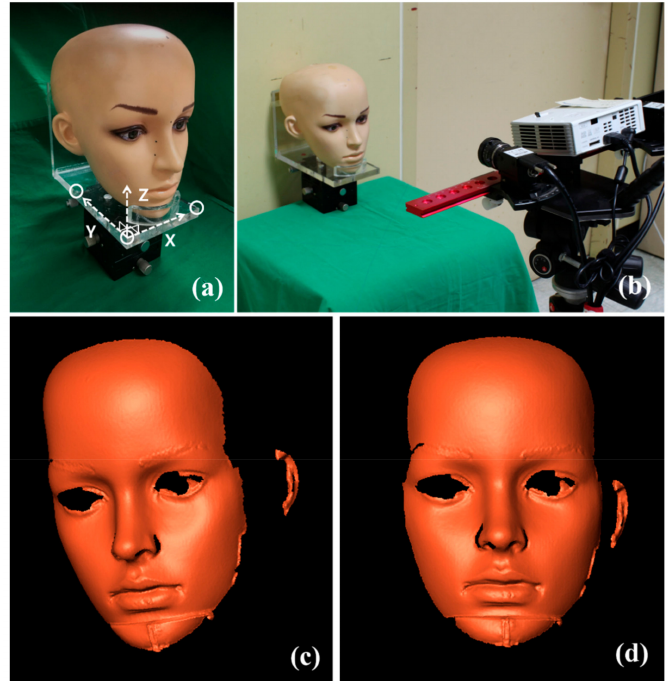
Figure 3. A mannequin phantom was mounted on an acrylic stand combined with a rotation stage, and the phantom’s true coordinate system (indicated by the dashed arrow) was determined using ceramic spherical markers (indicated by the circle) placed on the acrylic stand ( a ). The phantom in the NHP was optically scanned using a 3D scanner ( b ). The 3D scanned phantom model shown before calibration ( c ), and the model aligned with the global horizon after calibration ( d